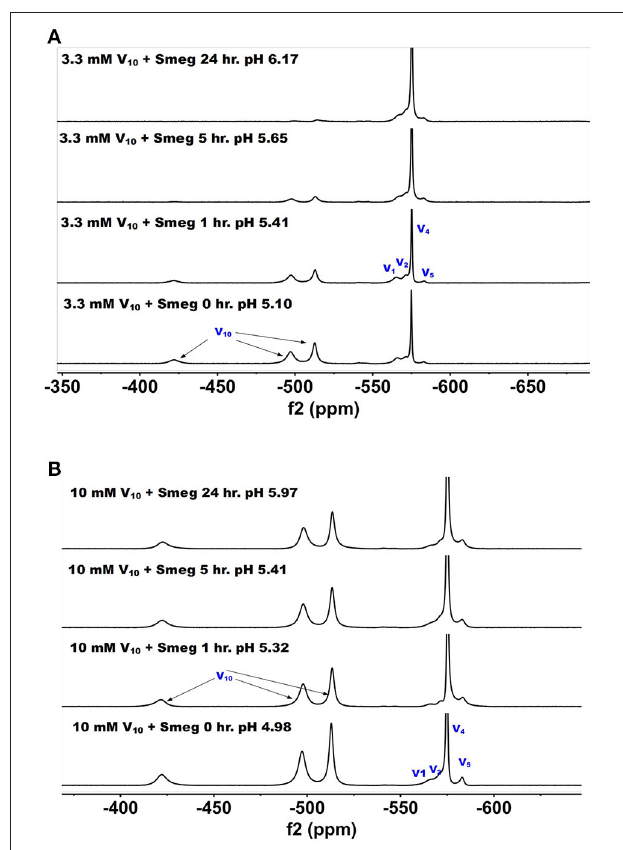
FIGURE 6 | The 51 V NMR spectra of media in which M. smeg had grown at 0, 1, 5, and 24 hr time points. Data for two concentrations are shown in (A) 3.3mM V 10 treatment (33mM V-atoms) and (B) 10mM V 10 treatment (100mM